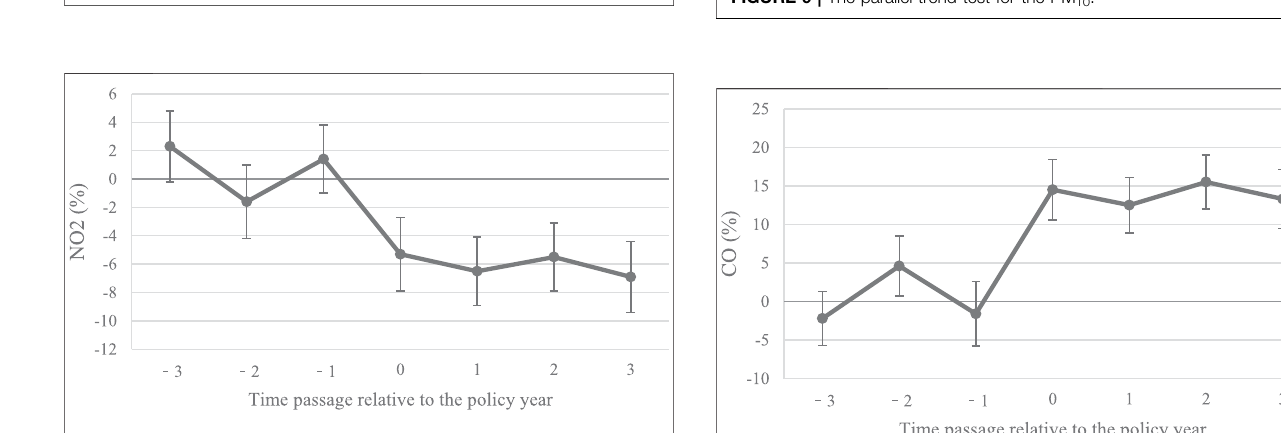
FIGURE 9 | The parallel trend test for the PM 10 .